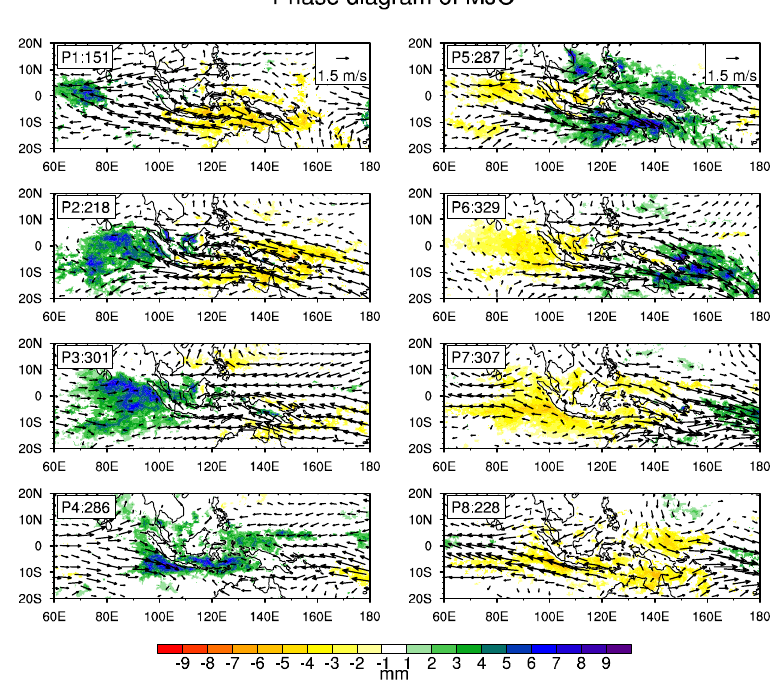
Figure 9. Composite anomalies of precipitation (shade, SI = 1 mm) and 925 hPa winds (vector, unit: 1.5 ms − 1 ) during eight phases of the MJO. Number in top-left represents the composite days in each MJO phase. Values and vectors exceeding the 95% confidence levels based on the two-tailed Student’s t -test are shown.